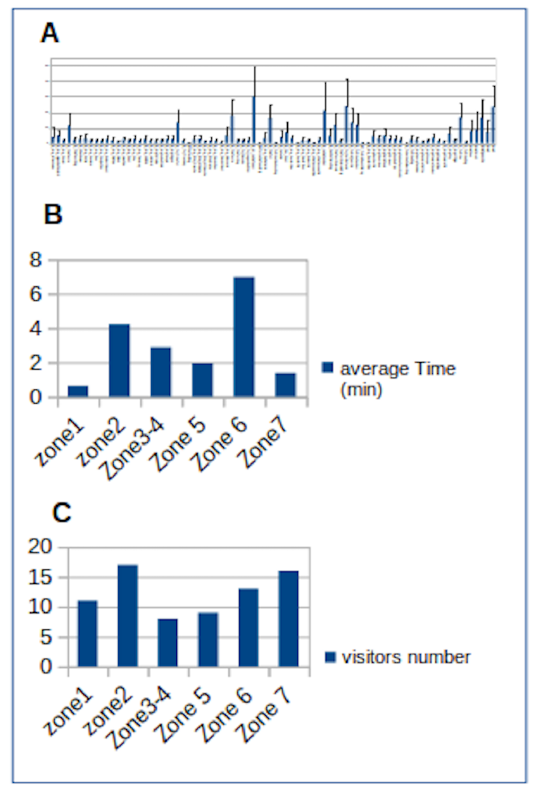
Figure 2. A. Graph of average time spent in each region of interest (ROI) in seconds with standard deviation (table of values is in supplementary material SM2). B. The average time in minutes spent by participants in each area. C. The maximum number of visitors in front of an item in each